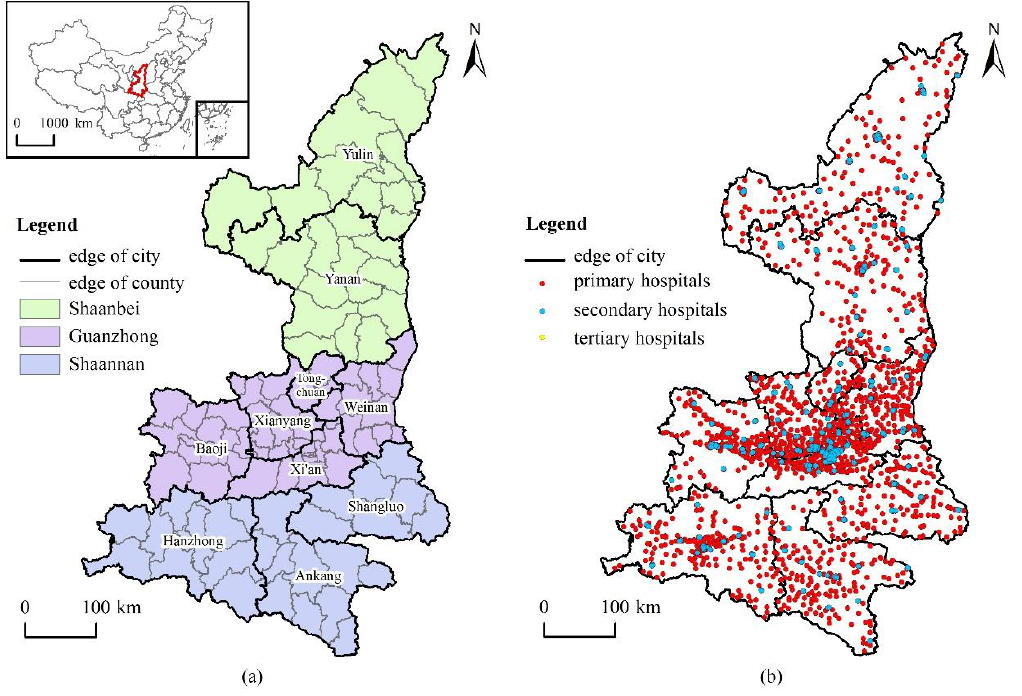
Figure 1. Study-area overview. ( a ) Shaanxi province; ( b ) public medical facilities.